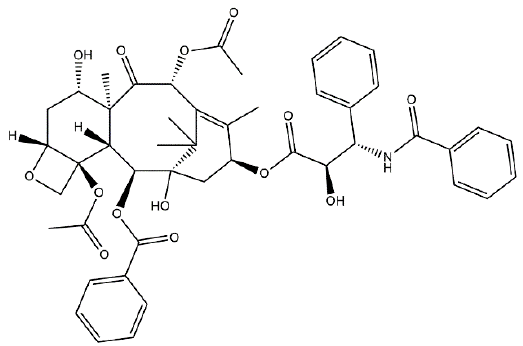
Figure 5. Schematic representation of paclitaxel’s chemical structure.